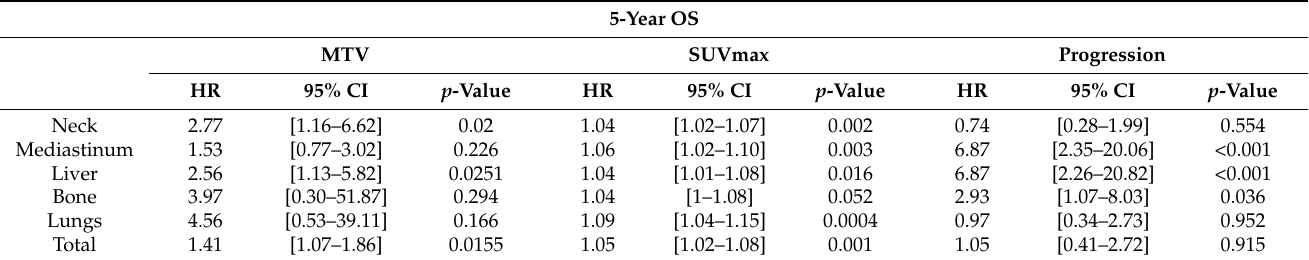
Table 6. Univariate Cox analysis of 5-year OS. HR: hazard